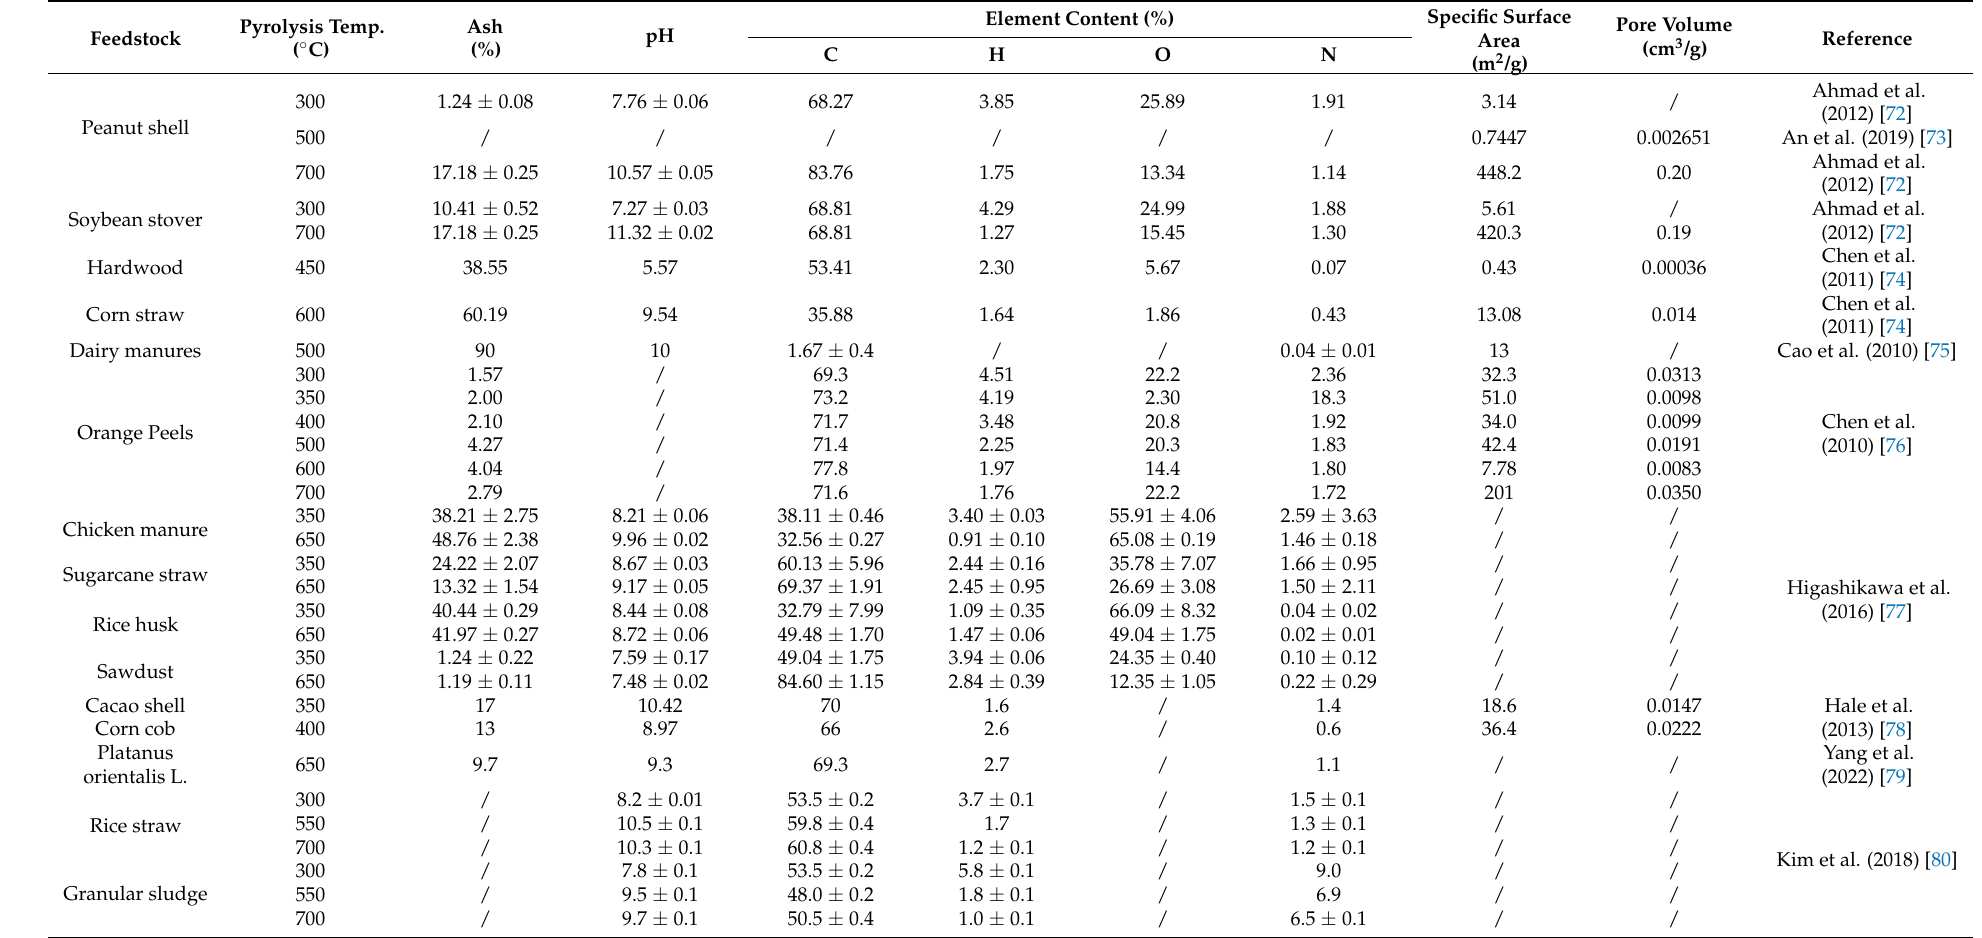
Table 2. Physicochemical properties of biochar prepared from diverse raw